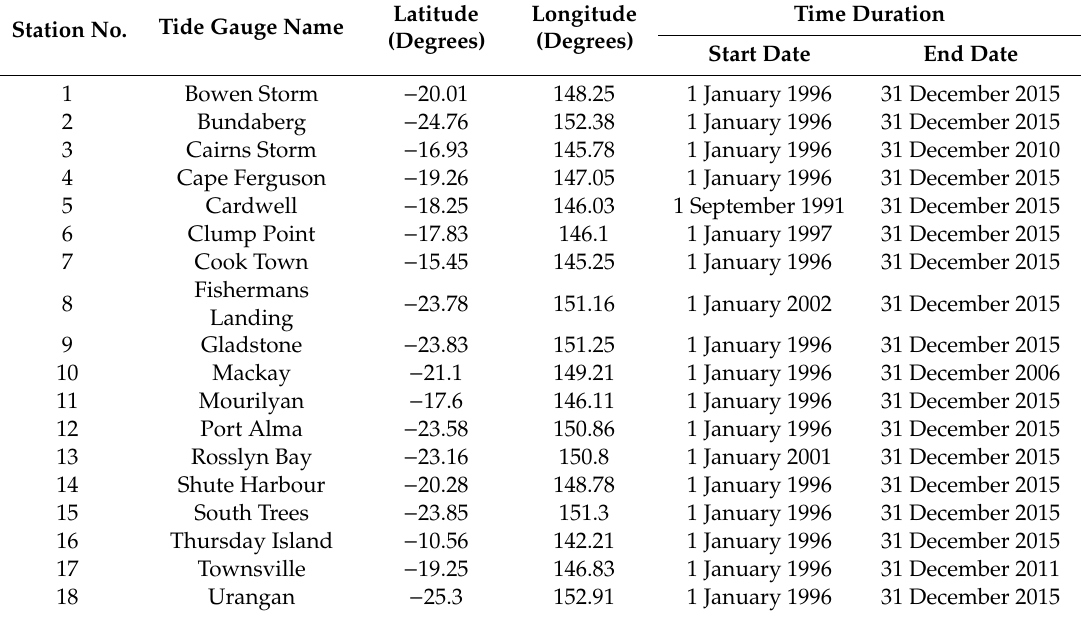
Table 1. The geographic positions and observation record periods of the coastal tide gauges. Station